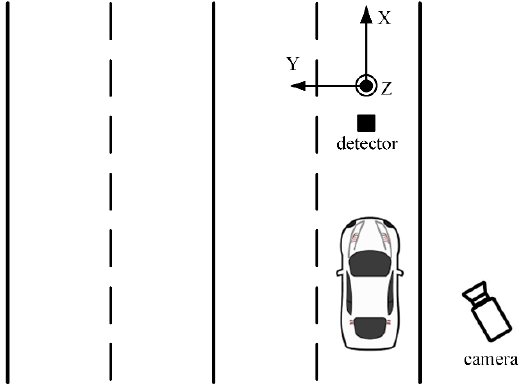
Figure 1. Sensor placement for data acquisition.